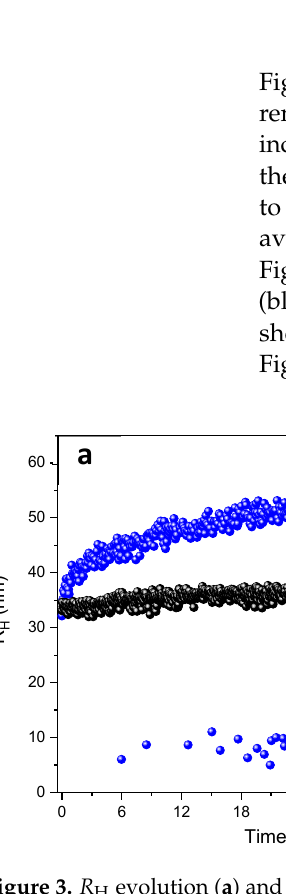
Figure 3. R H evolution ( a ) and intensity distribution ( b ) measured by DLS at pH ~7.4 ( • ) and pH ~5.0 ( • ) for the MPEO 44 - b - PCL 17 NPs after 48 h.